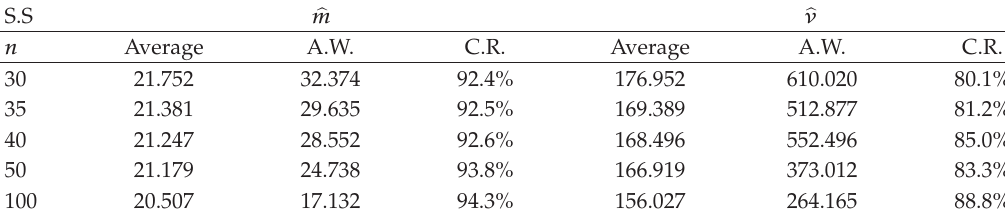
Table 4: Grouped data: τ 1 (cid:8) − 1 . 5, τ 2 (cid:8) 1, τ 3 (cid:8) 3 . 5, τ 4 (cid:8) 6, τ 5 (cid:8) 8 . 5. S.S